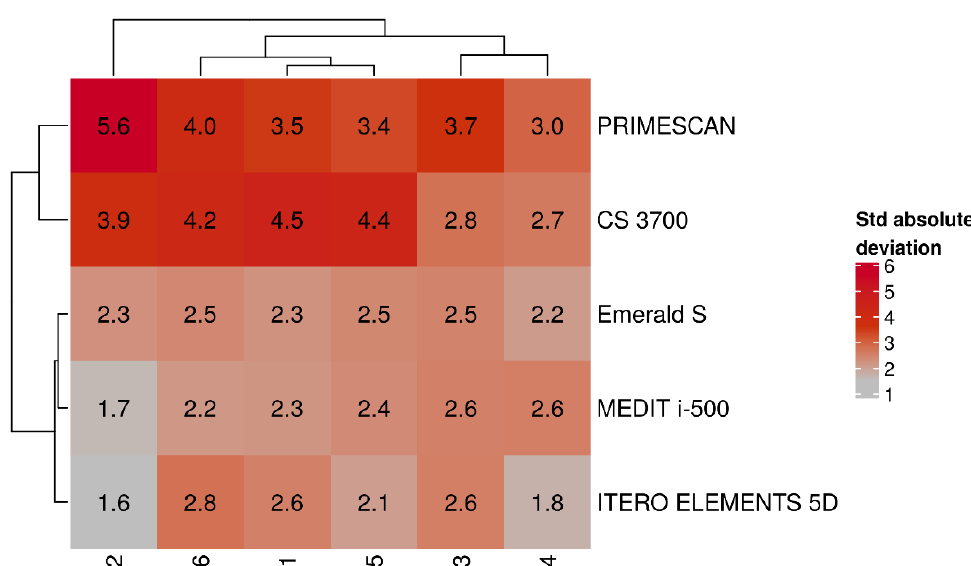
Figure 8. Results of IOSs and SBs biclustering based on average absolute deviation.